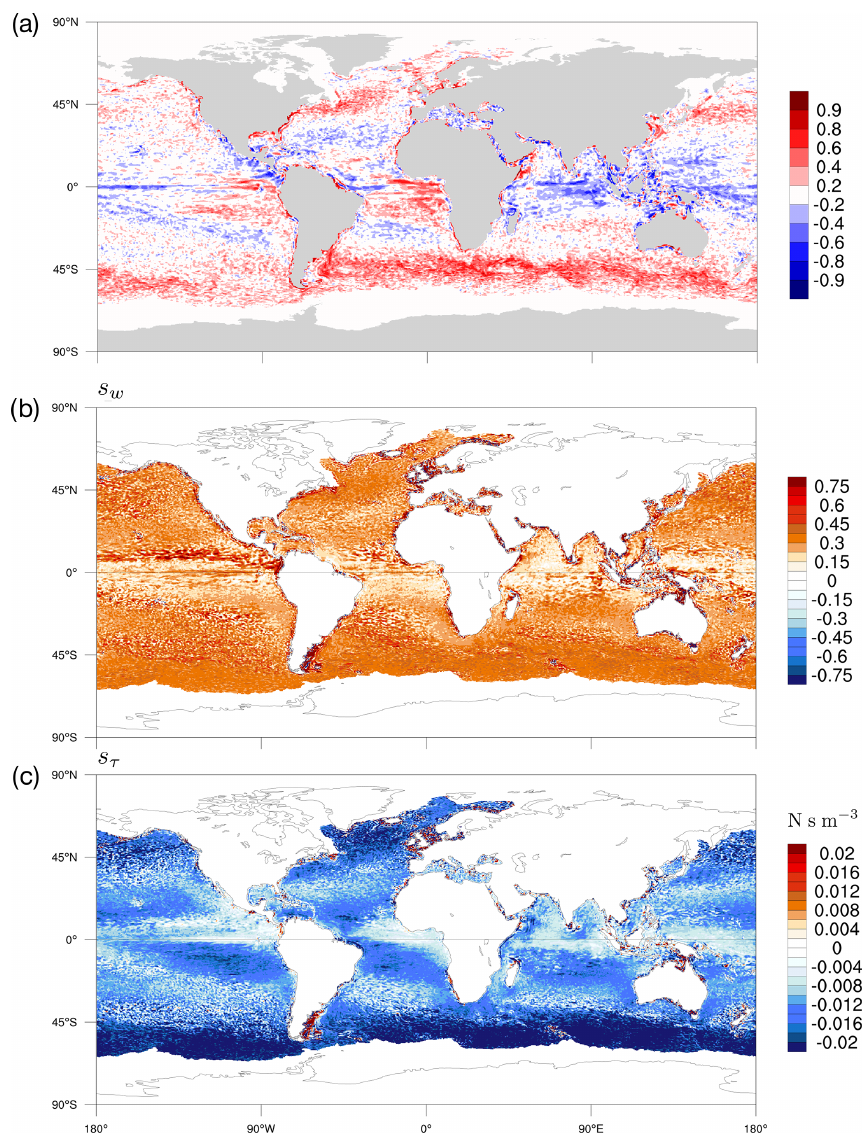
Figure 10. (a) Global map of temporal correlation of high-pass-filtered wind speed at the first vertical level of the ABL1d model with SST from NEMO. Both NEMO and ABL1d are configured at 0 . 25 ◦ resolution. (b, c) Global maps of the coupling coefficient between the surface current vorticity and the wind curl ( s w , b ) and between the surface current vorticity and the wind-stress curl ( s τ , c ) estimated from a 0 . 25 ◦ resolution coupled NEMO-ABL1d global simulation. The fields are first temporally averaged using a 29d running mean and spatially high-pass